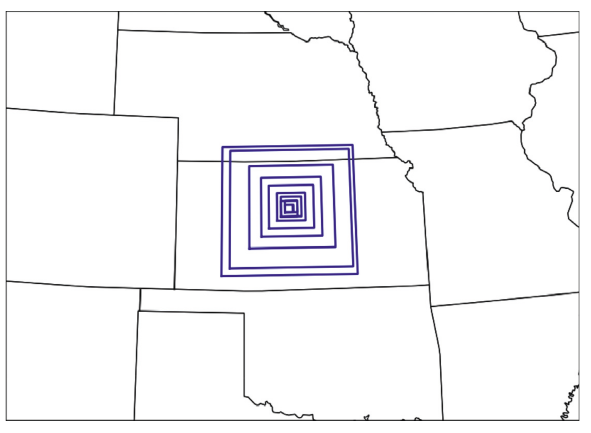
Figure 4: Wind farms (in outlined boxes) of the size ensemble shown for location 6 from Figure 1.